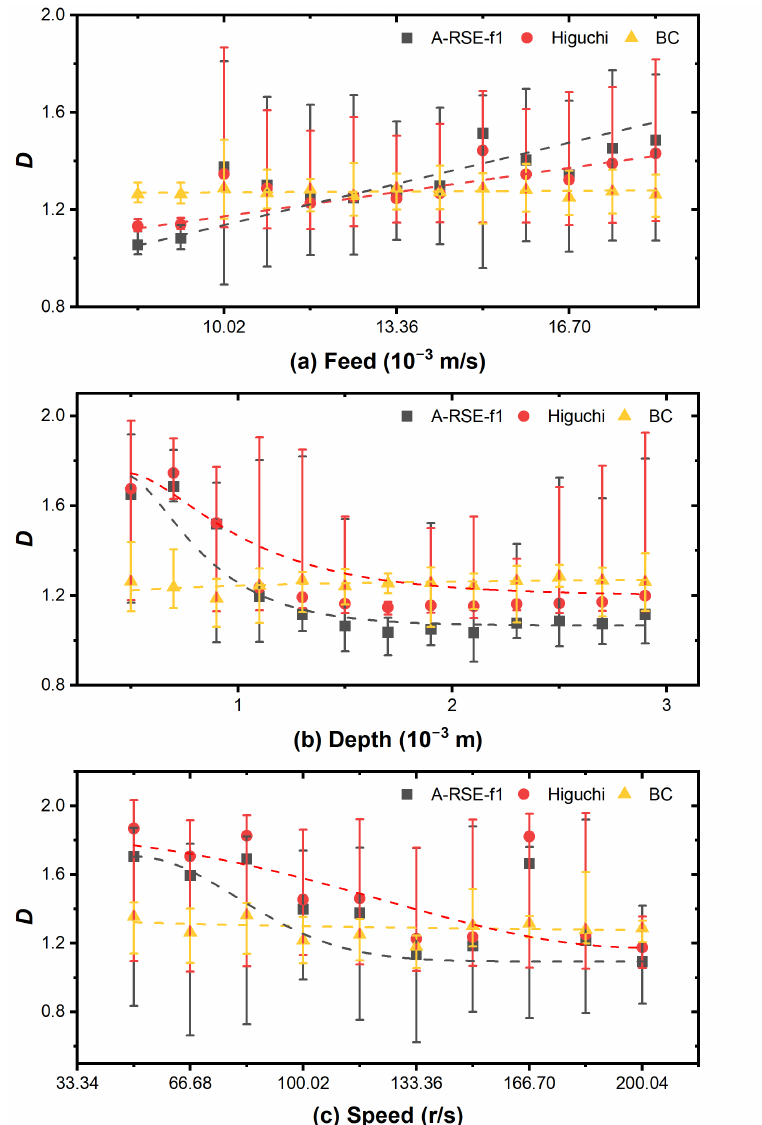
Figure 12. The calculation of D values of milling acceleration signal by A-RSE-f1, Higuchi, and BC algorithms, and the influences of: ( a ) feed, ( b ) cut depth, and ( c )